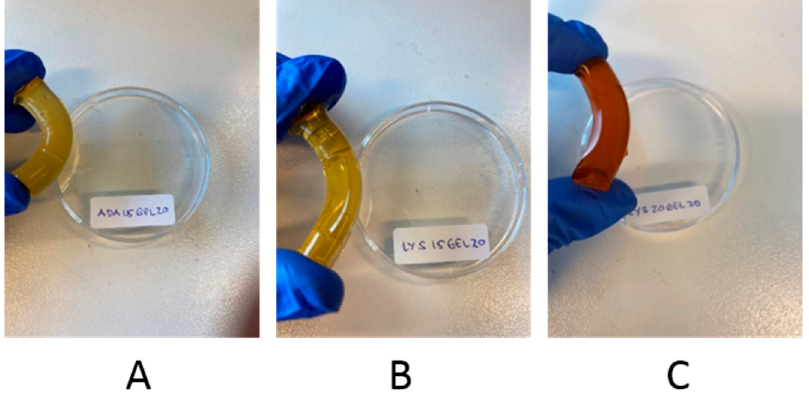
Figure 7. Photographs showing the resistance of self-healed hydrogels to bending: ADA15GEL20 ( A ); LYS15GEL20 ( B ); LYS20GEL20 ( C ).